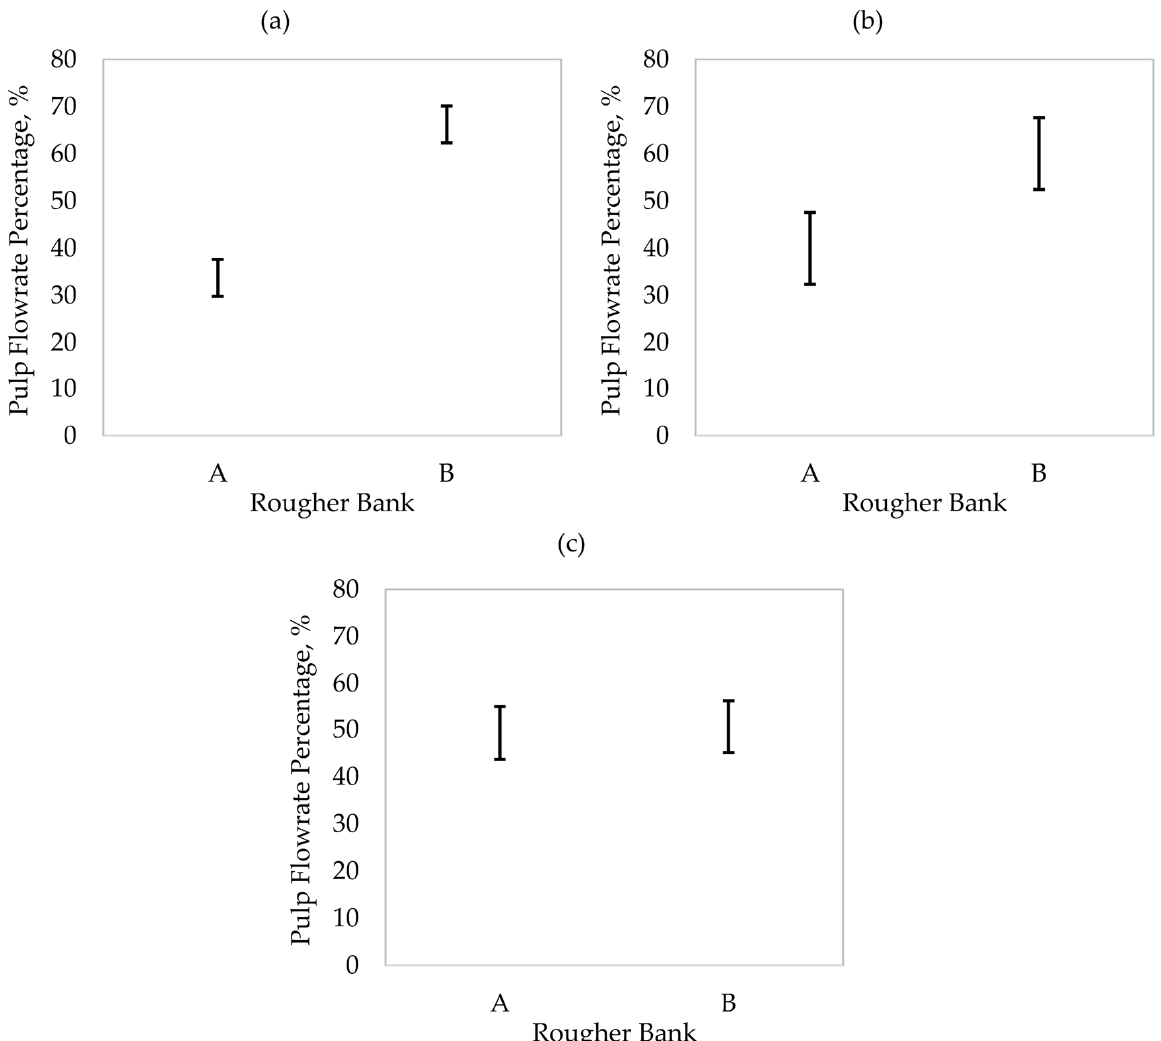
Figure 6. Pulp distribution between the rougher banks A and B: ( a ) Baseline; ( b ) Valve setting 1; ( c ) Valve Setting 2. The error bars correspond to the 95% confidence intervals of the mean.